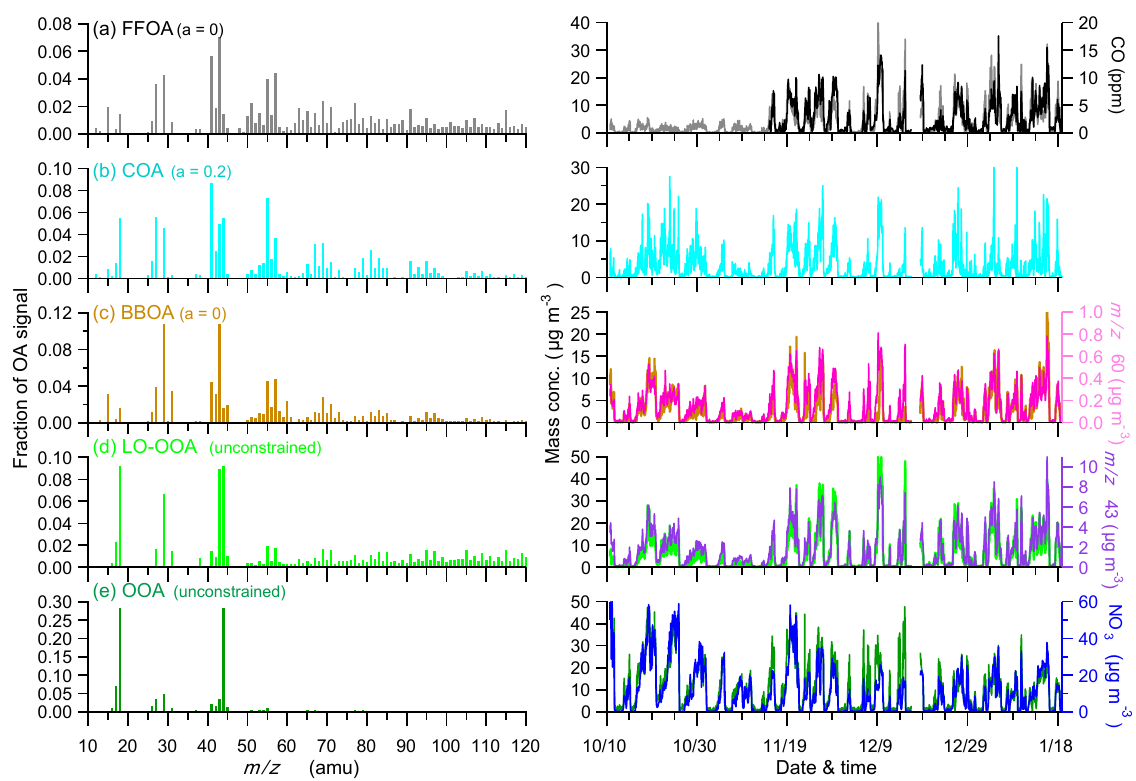
Figure 5. Mass spectra (left panel) and time series (right panel) of five organic aerosol (OA) factors including (a) fossil-fuel-related OA (FFOA), (b) cooking OA (COA), (c) biomass burning OA (BBOA), (d) less oxidized oxygenated OA (LO-OOA), and (e) oxygenated OA (OOA). Also shown in the right panels are the time series of other tracers including CO, nitrate, m/z 60, and m/z